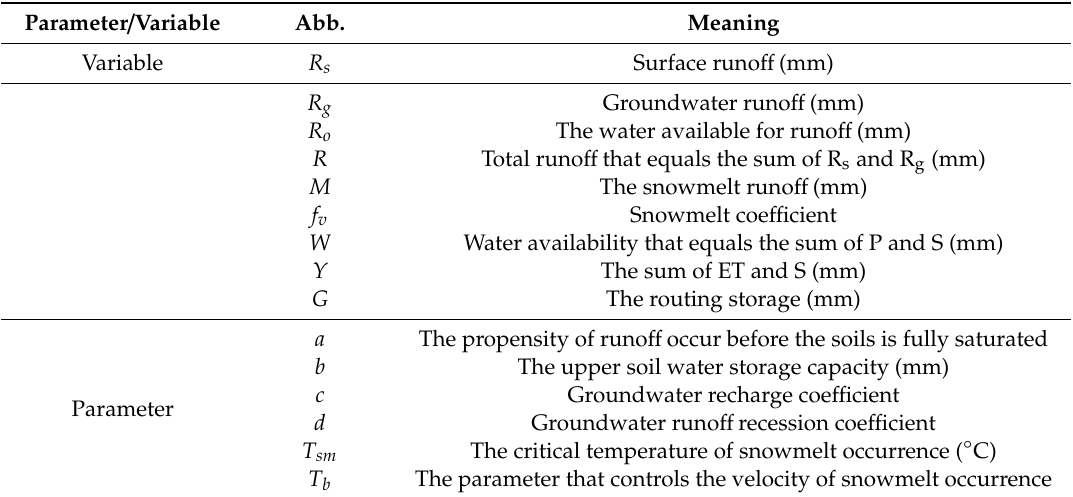
Figure 3. Model structures and key equations used in the abcd model that includes a snowfall-snowmelt module (hereafter called abcd-snow model). The descriptions of the variables and parameters are provided in Table 1. Table 1. Parameters and variables used in the abcd-snow